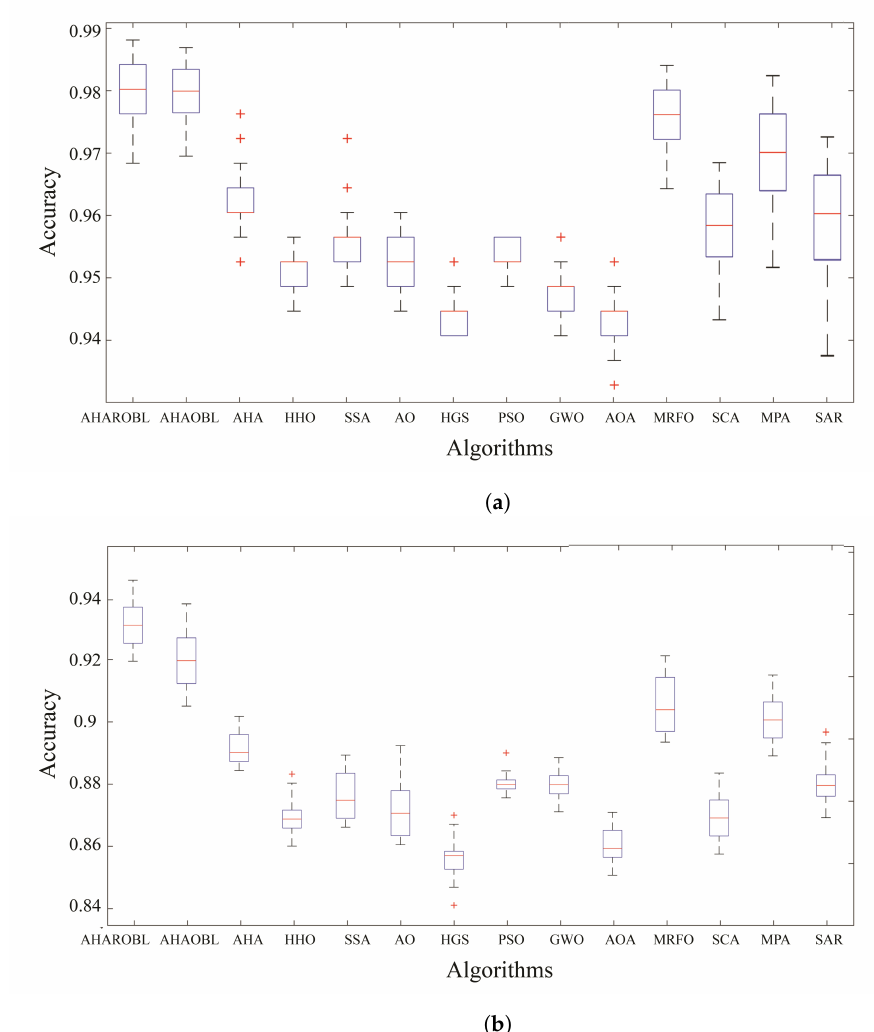
Figure 7. ( a ) Boxplot of the AHA-ROBL and AHA-OBL approaches versus other swarm intelligence algorithms using VGG19 and ( b ) boxplot of the AHA-ROBL and AHA-OBL approaches versus other swarm intelligence algorithms using